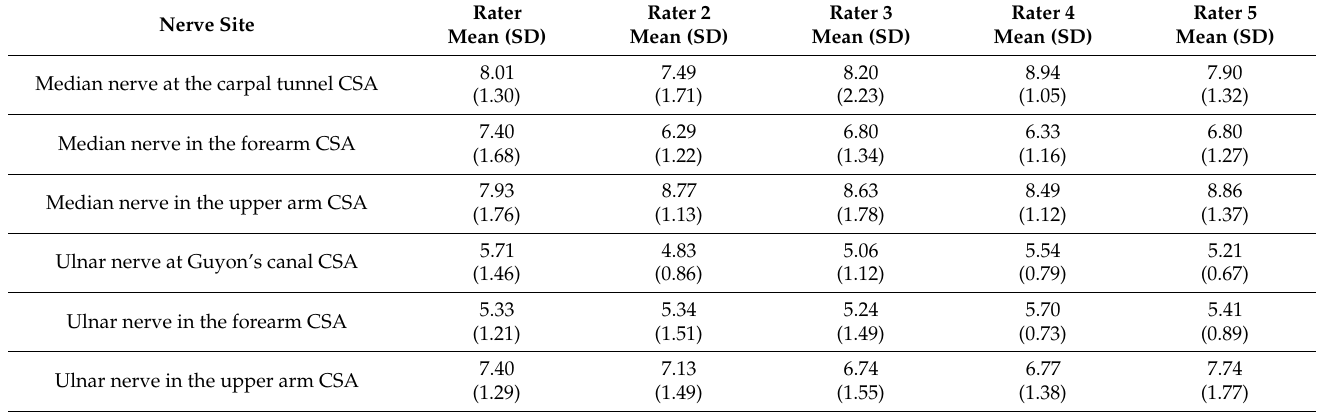
Table 1. Results of nerve cross-sectional area measurements (mm 2